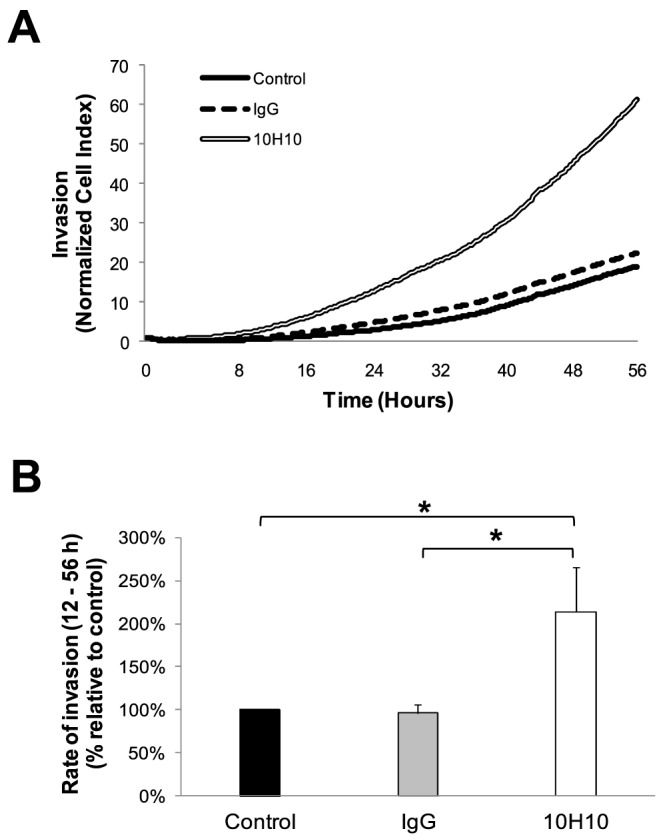
Enhancement of trophoblast invasion by mAb 10H10.(A) Representative cell index curves of HTR8 cells for invasion in the absence or presence of 10H10 or control mAb (5 µg/ml) measured with xCELLigence system. (B) Exogenous addition of mAb 10H10 (5 µg/ml) significantly increased HTR8 cell invasion at 12–56 hours, compared to untreated controls. Data are mean ± SEM from 3 independent experiments, *, P<0.05.